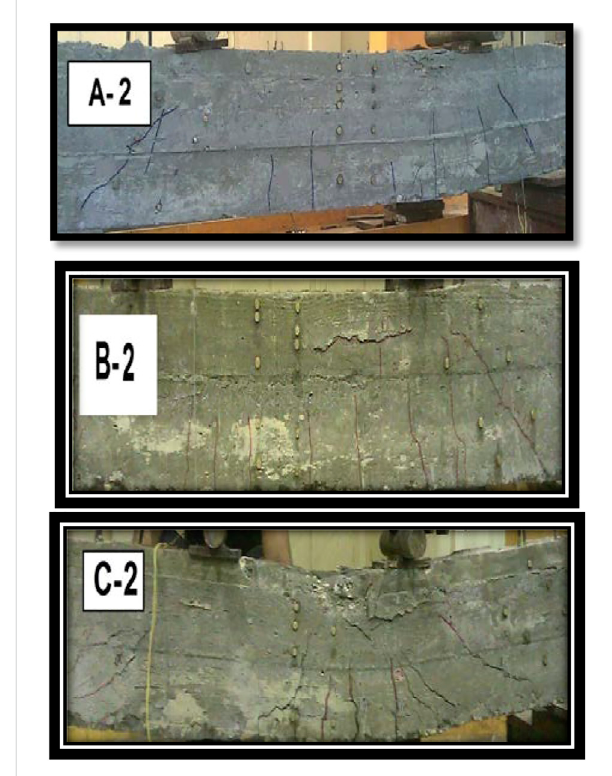
FIGURE 9 Propagation of cracks and modes of failure for HSFRC beams with a v f of 0.25% and varying a/d